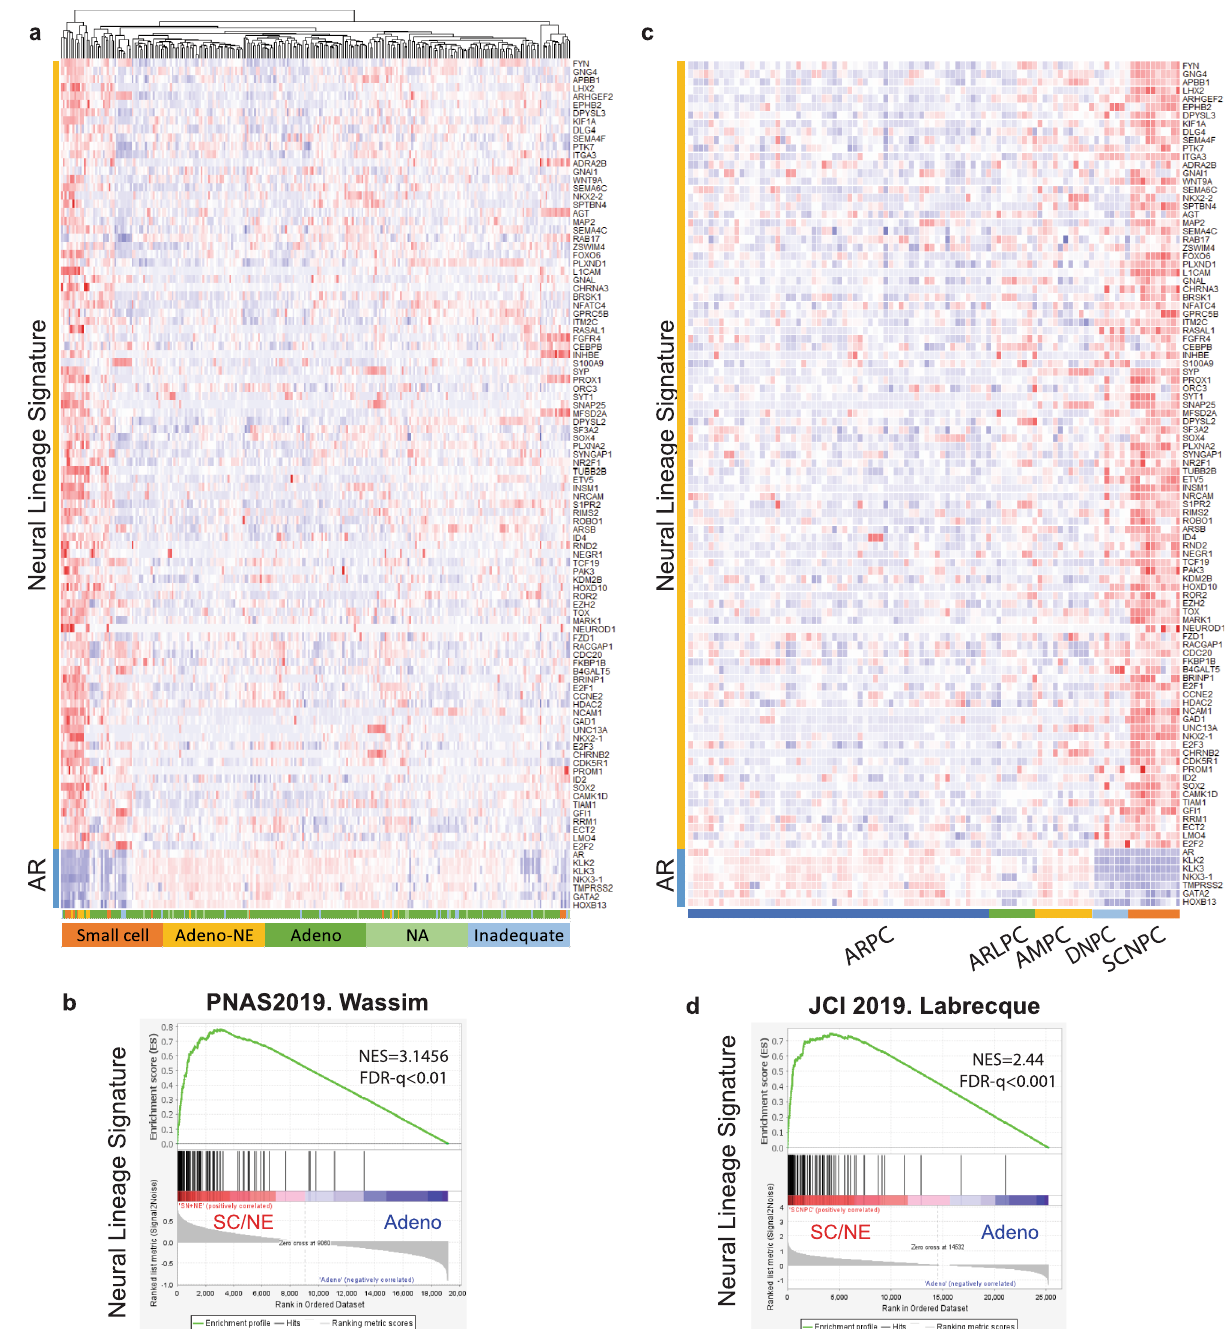
Fig. 4 The 95 NLS gene signatures stratify prostate cancer with neuroendocrine differentiation from prostate adenocarcinoma. a Hierarchical cluster of neural lineage signature genes in Wassim small-cell cohorts. Pathology classi fi cation (small cell, adenocarcinoma with neuroendocrine (NE) features, adenocarcinoma, not available and inadequate for the diagnosis) are indicated in the annotation track next to the heatmap. b GSEA enrichment plots for neural lineage signature in small cell and adenocarcinoma with NE feature groups with NES and FDR q values shown. c Hierarchical cluster heatmap of neural lineage signature genes in Labrecque cohorts. Molecular characteristic classi fi cation (AR high (ARPC), AR low (ARLPC), amphicrine expression of both AR and NE markers (AMPC), double-negative expression of both AR and NE markers (DNPC), and small-cell neuroendocrine SCNPC) are indicated in the annotation track next to the heatmap. d GSEA enrichment plots of neural lineage signature genes in Labrecque cohorts with NES score and FDR q values. NLS neural lineage signature, GSEA Gene Set Enrichment Analysis. * p < 0.05, ** p < 0.01, *** p <